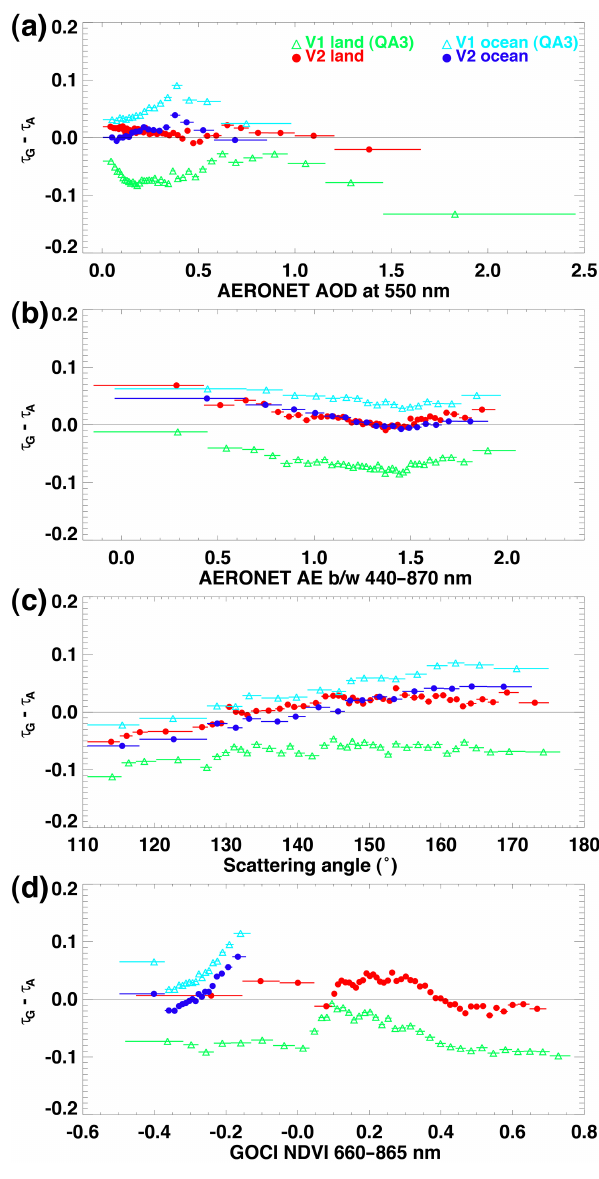
Figure 6. Difference between GOCI and AERONET AOD in terms of (a) AERONET AOD, (b) AERONET AE, (c) scattering angle, and (d) GOCI NDVI. Each point represents the 50th percentile of 1000 collocated data points sorted in ascending order for each x axis value. The horizontal line through each point represents the range of collocated data